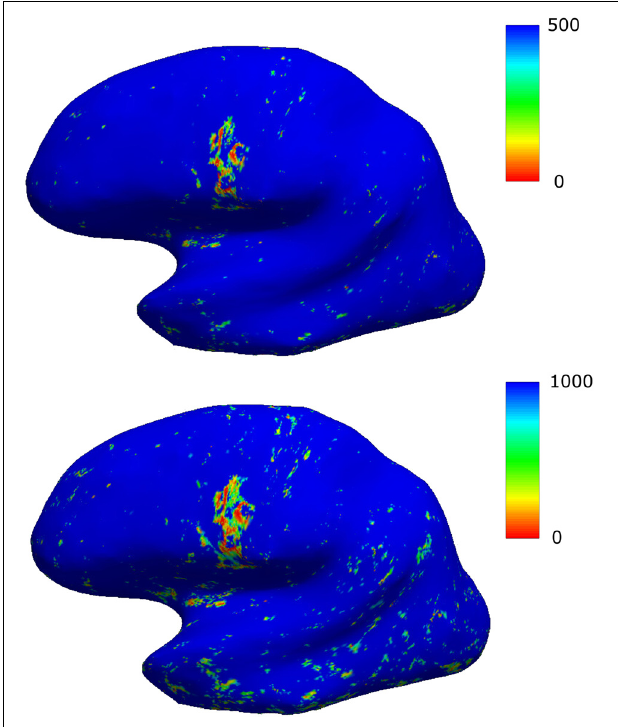
FIGURE 1 | Results of the surface-based analysis demonstrated for a representative patient. Two different scalings are presented, the scaling in the first row resulting in an improved signal-to-noise-ratio. The area with focally decreased values (hot colors) corresponds to the location of an